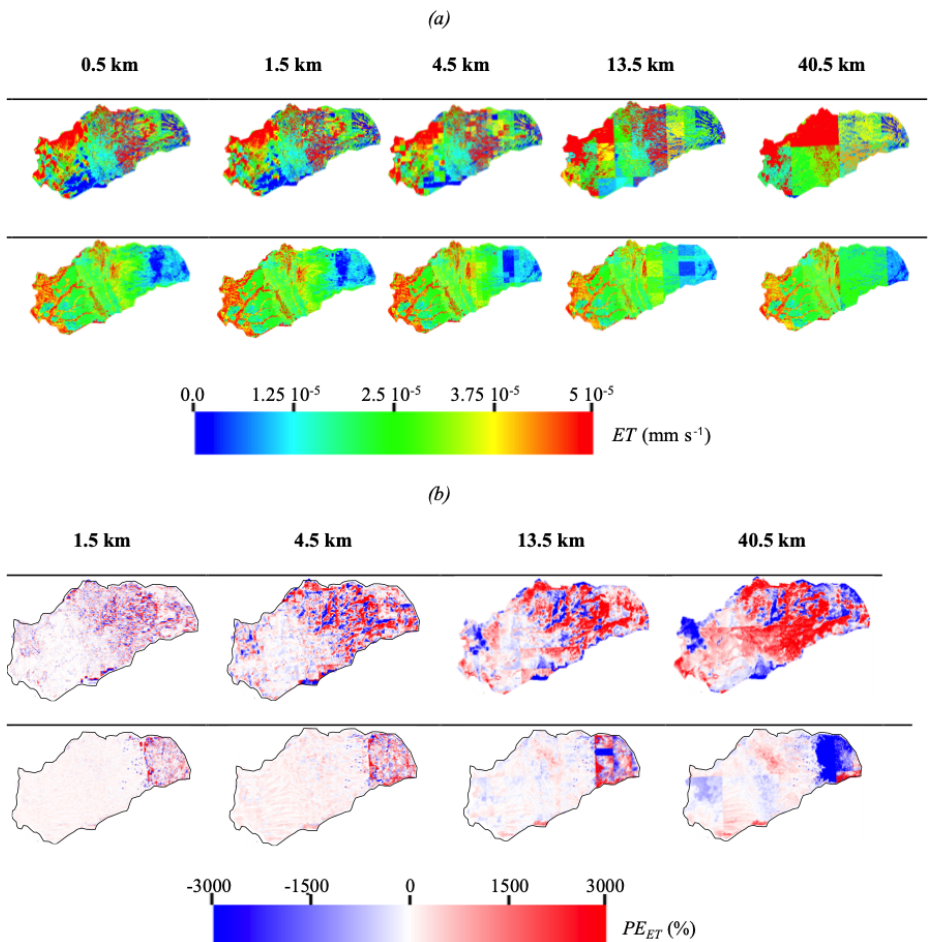
Figure 6. Spatial distributions of (a) the ET obtained with the five spatial resolutions of meteorological forcing and (b) the percent error of ET (PE ET ) with respect to the highest spatial resolution of meteorological forcing (0.5km). Results are shown at the first day of the simulation (WY day 0, in October) and during the time at which peak differences are observed (WY day 167, in